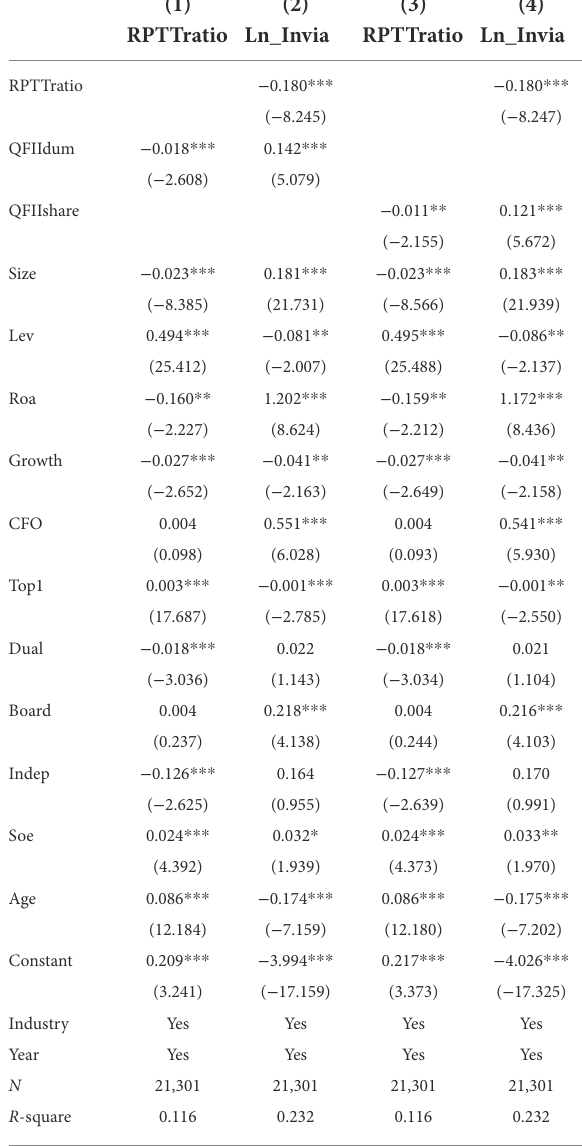
TABLE 5B The impact of QFII on innovation quality: Mechanism test based on the firm’s “tunnel”